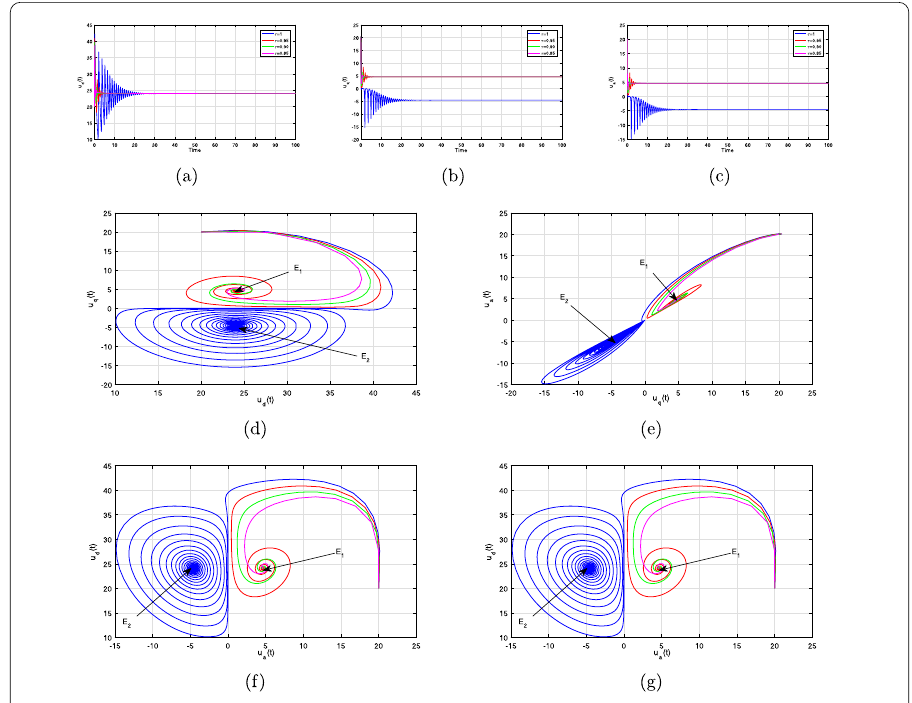
Figure 3 Simulations of Example 2 for time-fractional brushless DC motor (10) in the Liouville–Caputo